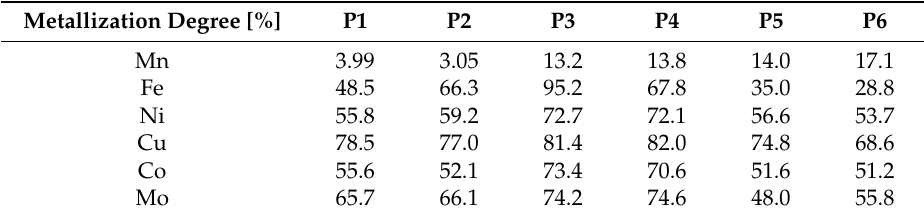
Table 3. Metallization degree of samples P1–P6.